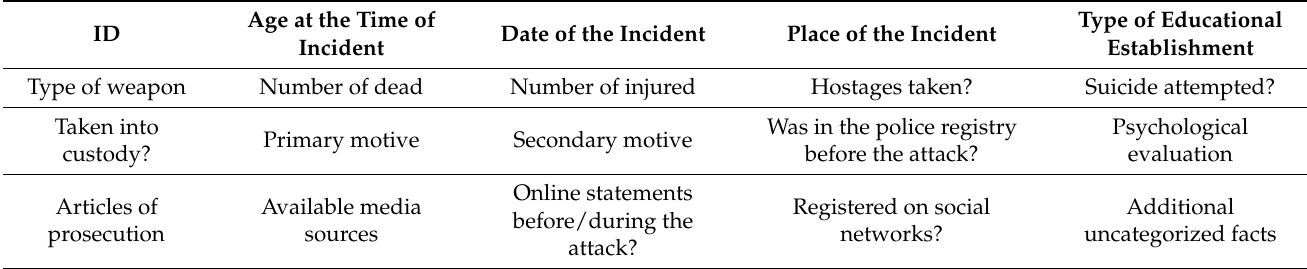
Table 1. Key attributes collected after the automatic search through the open crime